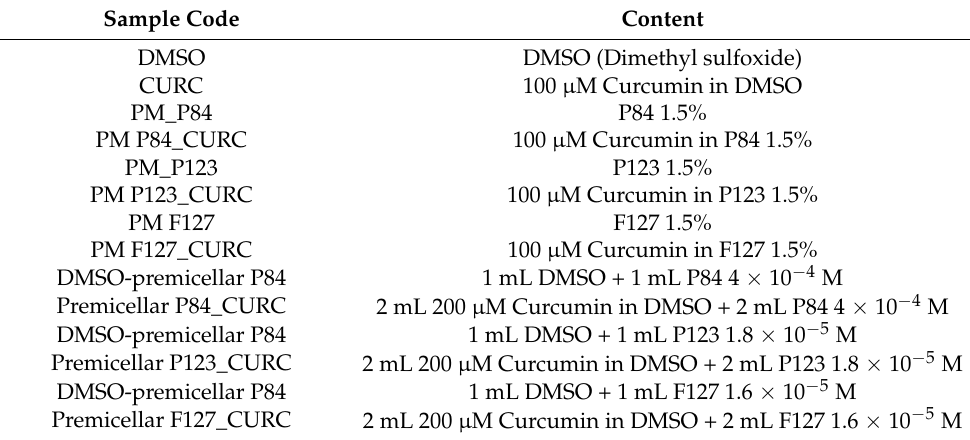
Table 2. Sample composition and codification.